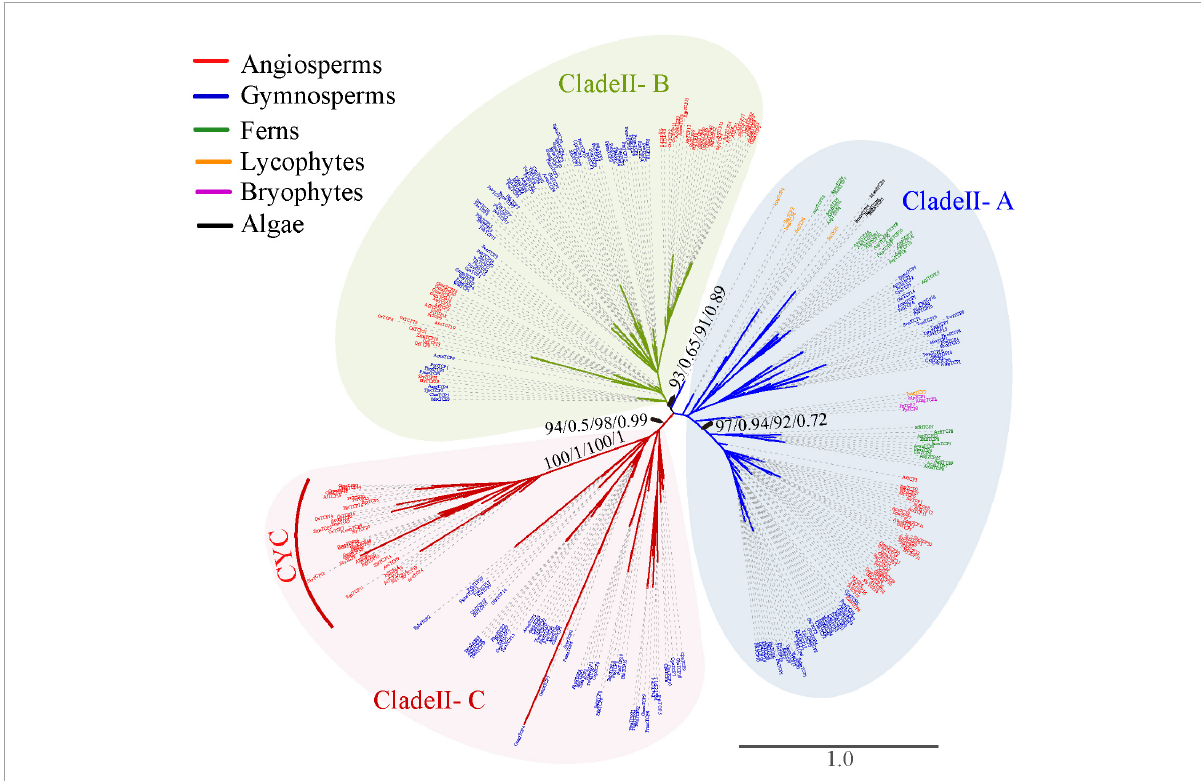
FIGURE3 Phylogenetic tree of Class II TCP genes constructed based on the amino acid sequences of the TCP domain and the upstream conserved sequences. The tree was not rooted. Branch lengths indicate the number of amino acid residues substitutions per site and are drawn to scale. Numbers associated with nodes are UFBoot support values and posterior probability in the phylogeny analysis based on amino acid sequences (first and second) and CDS (third and fourth), respectively. All species abbreviations are listed in Supplementary Table 1 .